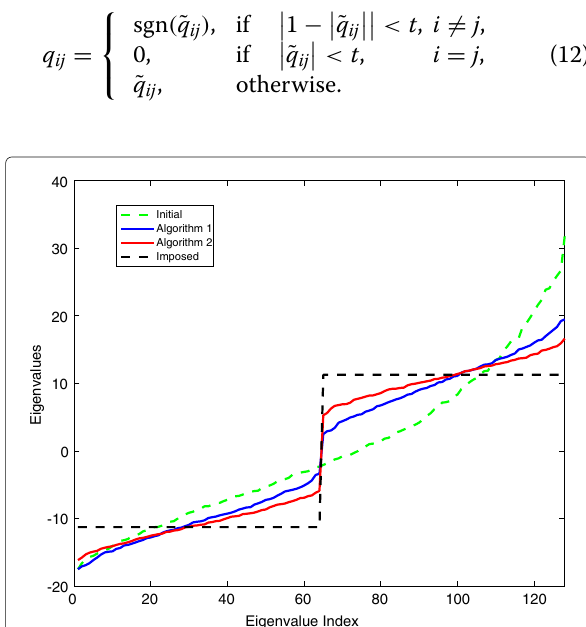
Fig. 1 The spectrum of the signature matrix of a 64 × 128 random Gaussian matrix before and after processing the matrix with Algorithms 1 and 2. The black dotted line stands for the spectrum of the signature matrix corresponding to a 64 × 128 ETF